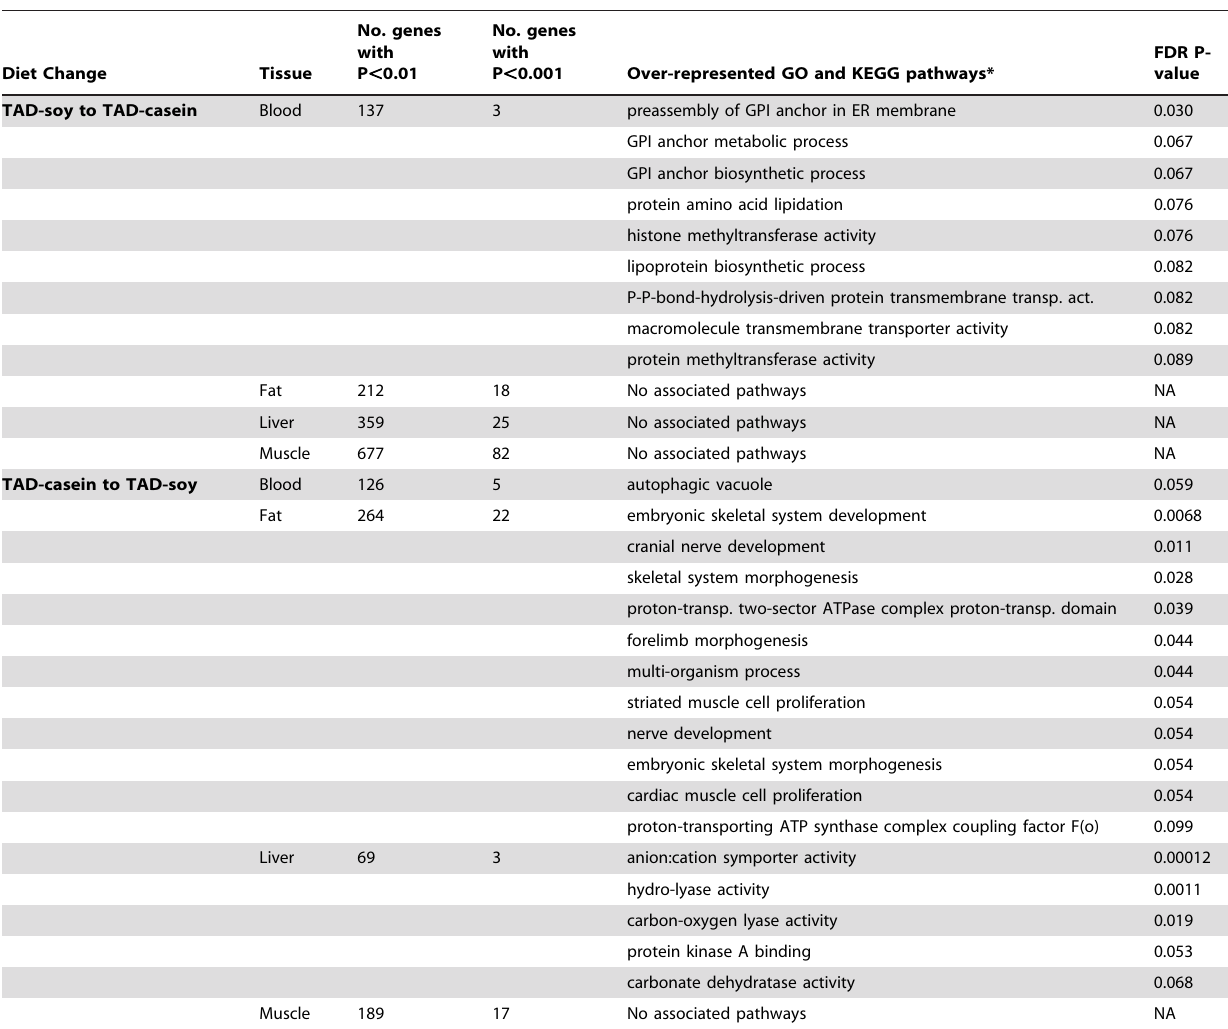
Table 2. Pathways detected after TAD diet changes.